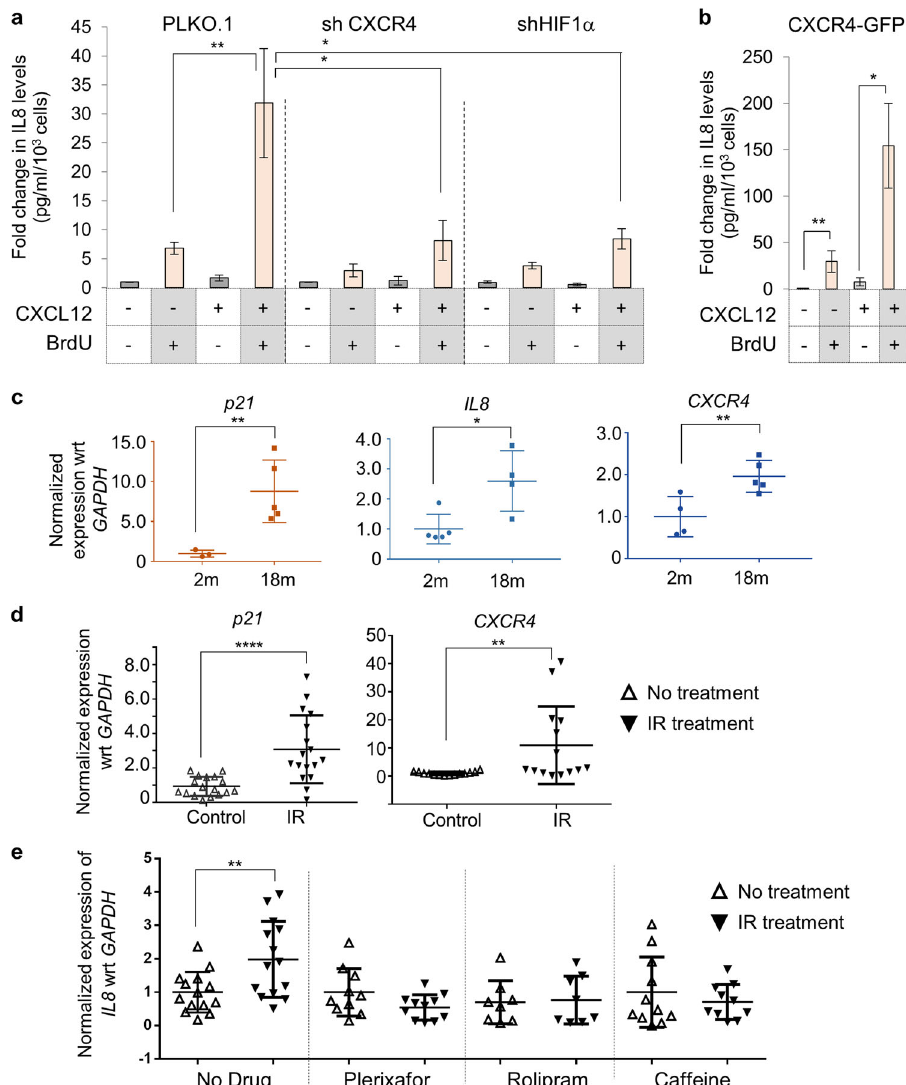
Fig. 6 Role of CXCR4 receptor and its upregulation in DNA-damage associated in fl ammation. a Effect of CXCR4 receptor level changes on enhanced in fl ammation during DNA damage. IL8 levels measured from HeLa cells where expression of CXCR4 (left) or HIF1 α (right) was knocked down using gene speci fi c shRNAs. Experiments were performed as described in Fig. 5a. b Analysis of in fl ammatory response in CXCR4-OE cells. CXCR4-GFP cells were treated with BrdU or BrdU + CXCL12 and IL8 ELISA was performed. c Analysis of gene expression changes during organismal aging. Quantitative RT-PCR analysis for the expression of p21 , IL8 and CXCR4 in liver tissues of 2-months and 18- months old BALB/c mice. The values were normalized to GAPDH expression levels. d Analysis of gene expression changes during IR mediated damage in C57BL/6 mice. Quantitative RT-PCR analysis for the expression of p21 and CXCR4 in irradiated animals. e Analysis of IL8 levels during irradiation and in response to various inhibitors. Animals were treated with Caffeine (Caff), Plerixafor (Plx) or Rolipram (Roli) alone or with these compounds and irradiation. Gene expression changes for IL8 was tested in liver as mentioned in Fig. 6c. For all experiment, n > 5 and as indicated in the fi gure panels. p -value or signi fi cance was determined by ANOVA and Bonferroni ’ s multiple comparison test. Signi fi cance ( p value) is represented as *, * ≤ 0.05, ** ≤ 0.01, *** ≤ 0.001, and **** ≤ 0.001 and ns, where >0.05 for “ not signi fi cant levels of Cxcl12 remained unaltered during natural ageing as well (6 Grays) of ionizing radiation (IR), which causes signi fi cant DNA as IR-induced accelerated ageing (Supplementary Fig. S6d). For damage 40,41 and here also upregulation of p21 , Cxcr4 and Cxcl15 evaluating role of ATM kinase and CXCL12-CXCR4 axis in damage- (IL8) was recorded (Fig. 6d), con fi rming that the response induced in fl ammation, mice were irradiated while being treated underlying DNA damage and aging is similar. To speci fi cally with caffeine (Caff), which inhibits ATM kinase 25 or with Plerixafor con fi rm presence of DNA damage response, we probed for phospho-H2A.X levels through western blotting and recorded (Plx), a CXCR4 antagonist 42 or with Rolipram (Roli), PDE4A elevated levels in physiologically aged 18-month-old mice inhibitor, 43 based on the in cellulo fi ndings reported above. compared to 2-month-old mice as well as in IR-treated mice Treatment with these inhibitors suppressed the DDR mediated compared to untreated (Supplementary Fig. S6c, densitometric upregulation of IL8 in the liver (Fig. 6e), indicative of reduction in data is shown). Next, using the IR-mediated DNA damage mouse in fl ammation, a hallmark of tissue injury through the same DDR model, the effect of CXCR4-CXCL12 signaling on in fl ammation and cascade reported above. We also evaluated expression status of associated tissue injury was analyzed. Interestingly, changes in IL10, another cytokine which has been linked to senescence